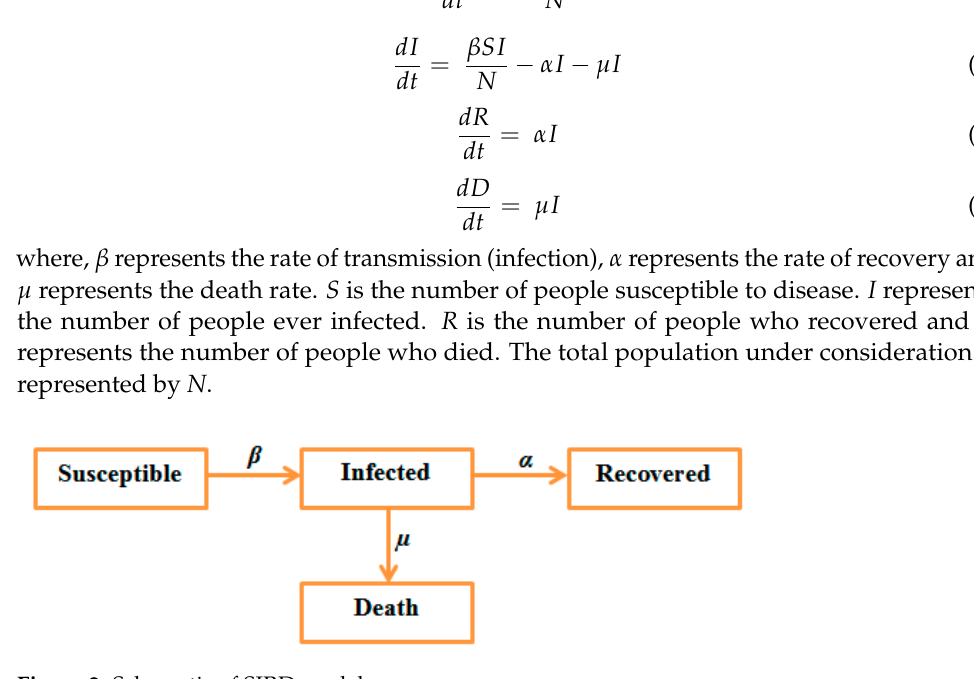
Figure 2. Schematic of SIRD model.